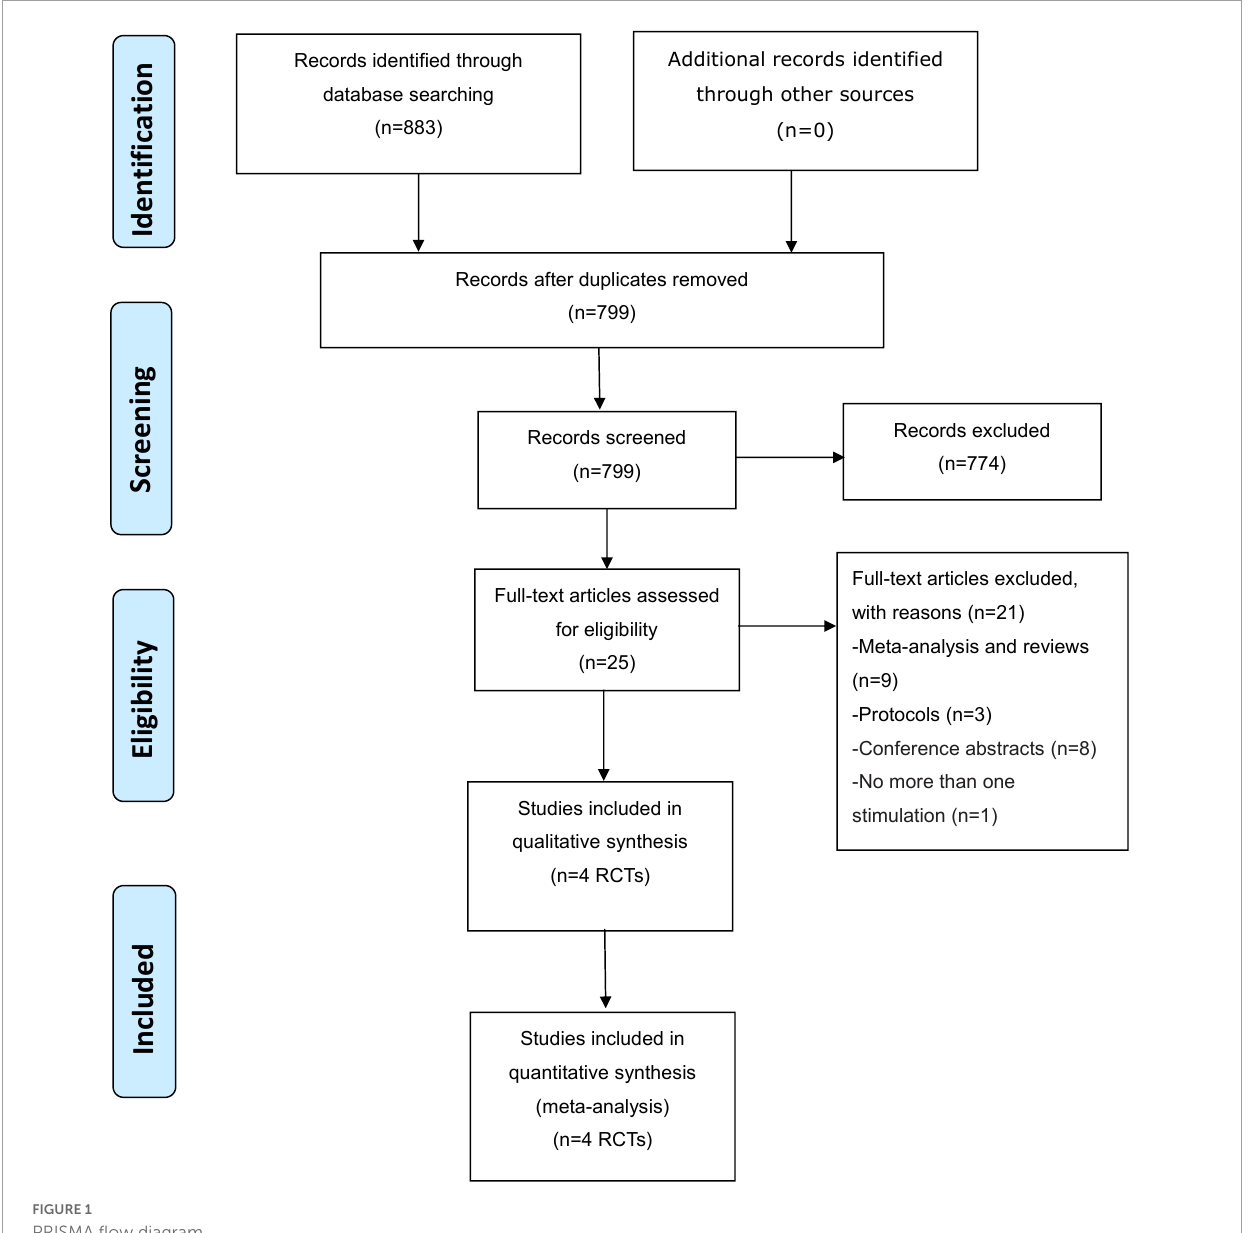
FIGURE1 PRISMA flow